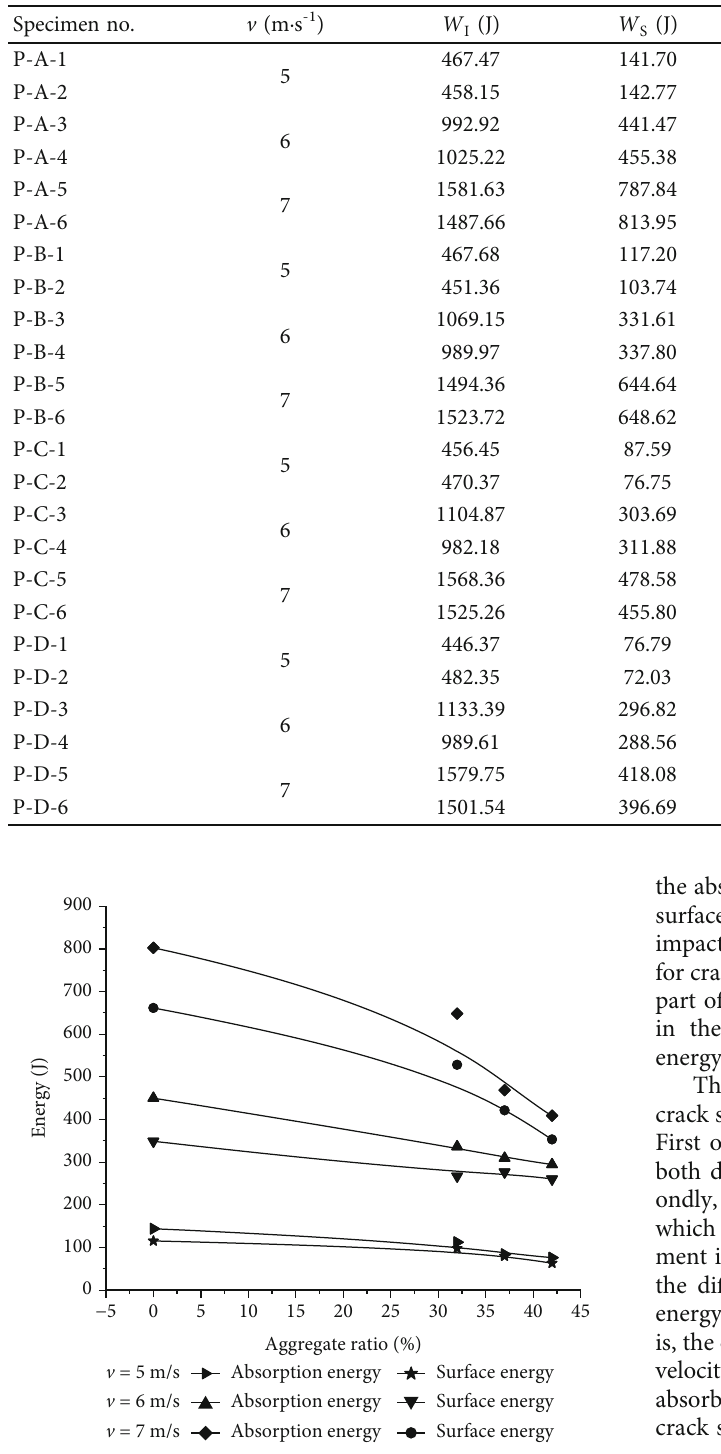
Figure 9: The relationship between the absorption energy and crack surface energy of the specimens and the aggregate rate.